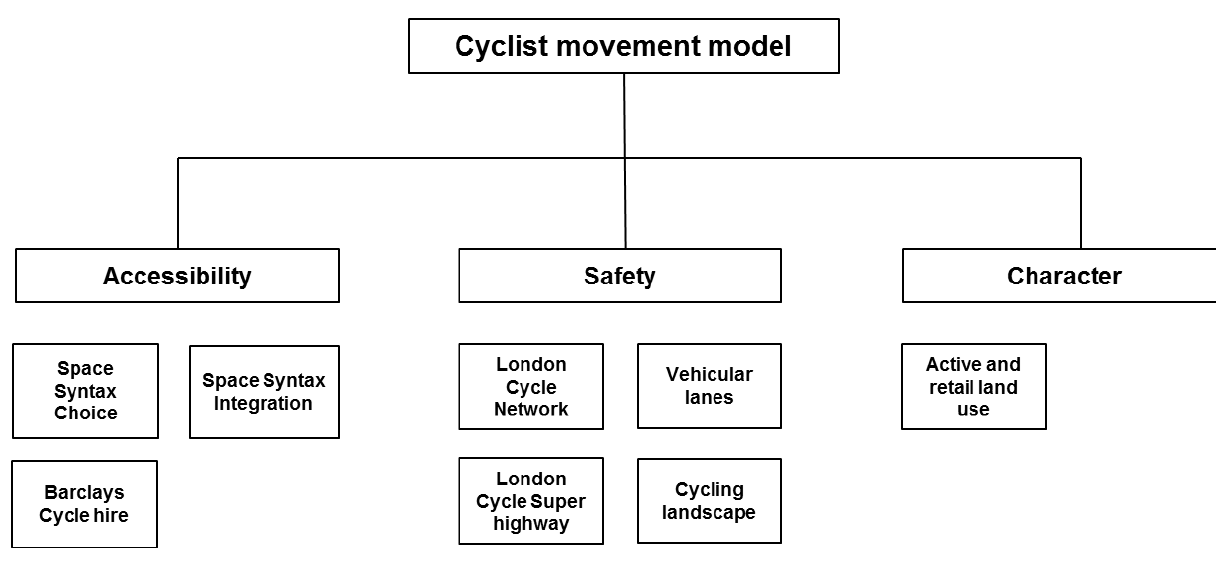
Figure 2. Proposed Cyclist movement model.